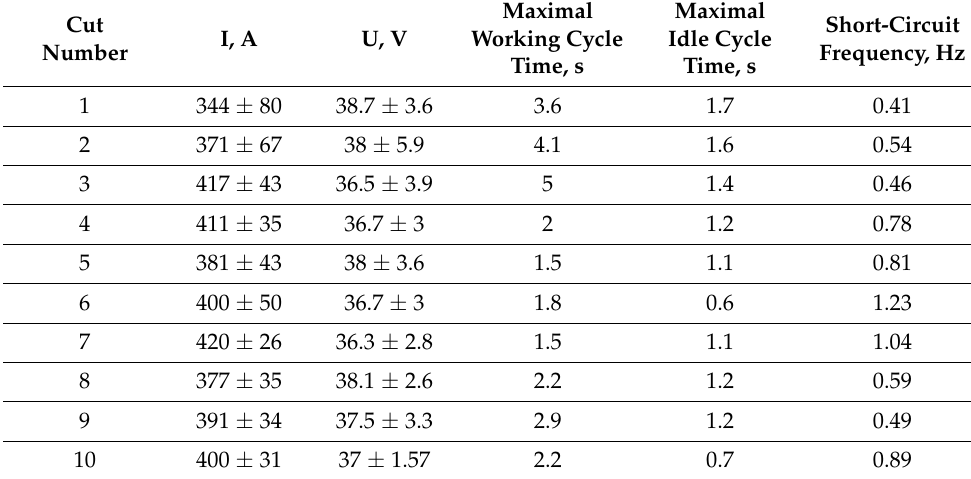
Table 4. Parameters of underwater wet cutting of 10 KhSND steel with PPR-APL1-1 wire.